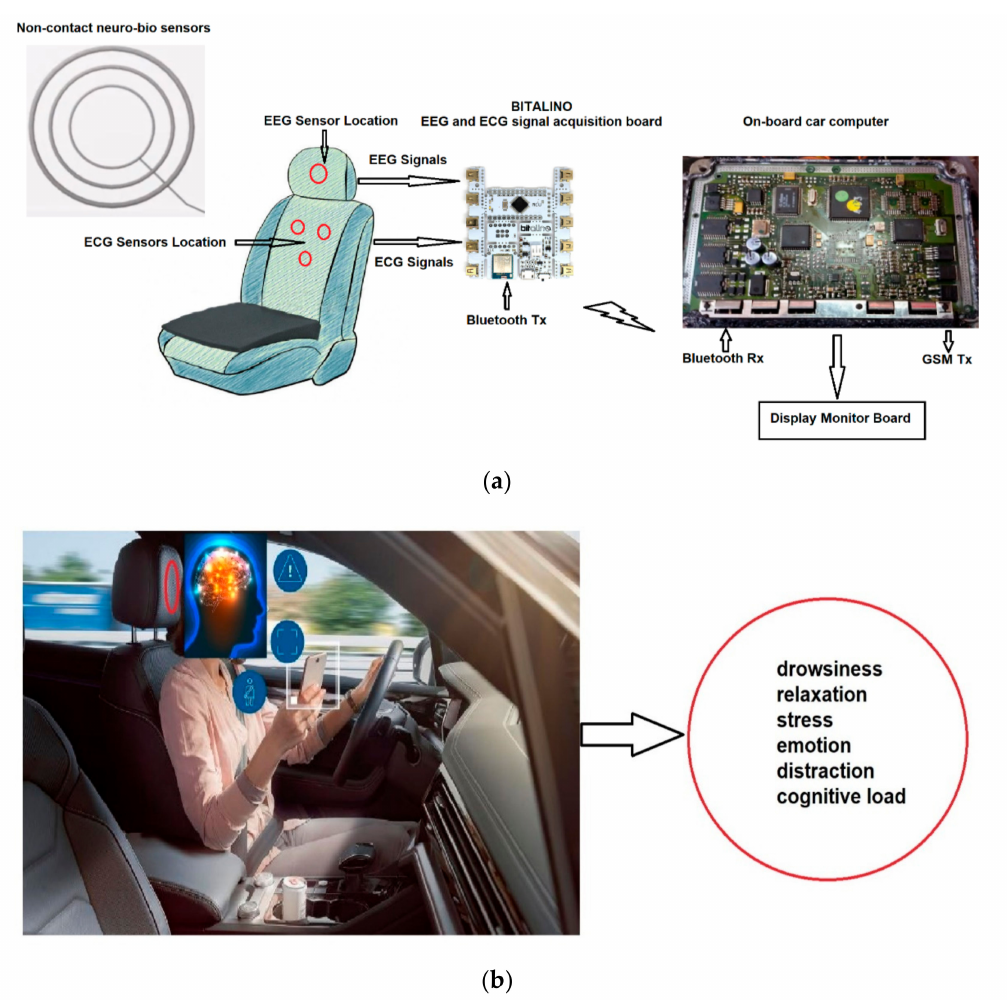
Figure 10. ( a ) IoT system block diagram for the acquisition of biomedical information; ( b ) shows the location of the EEG non-contact sensor in the head restraint of the driver/passenger seat, which acquires the cerebral signals from a distance of max 10 cm and the analyzed cognitive